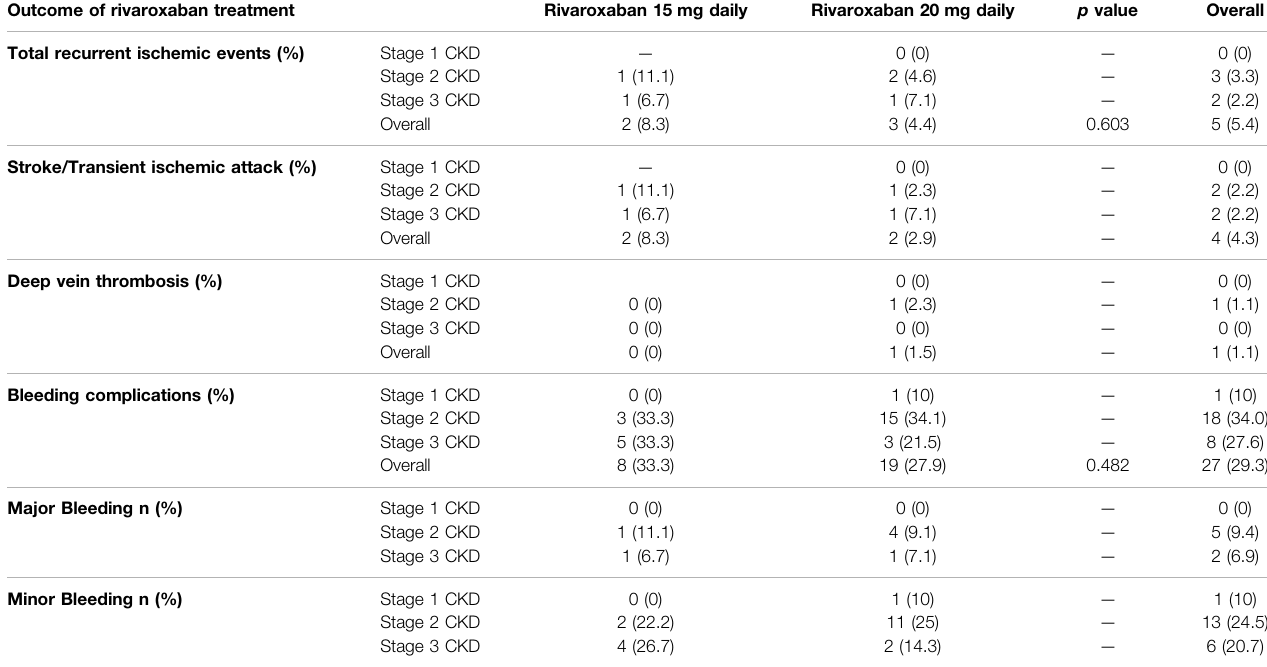
TABLE 3 | Rate of clinically signi fi cant events in patients of different stages of CKD.